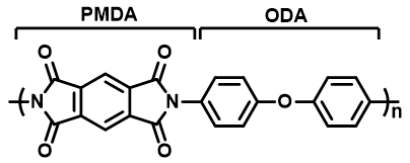
Figure 1. Schematic diagram of the molecular structure of the polyimide.